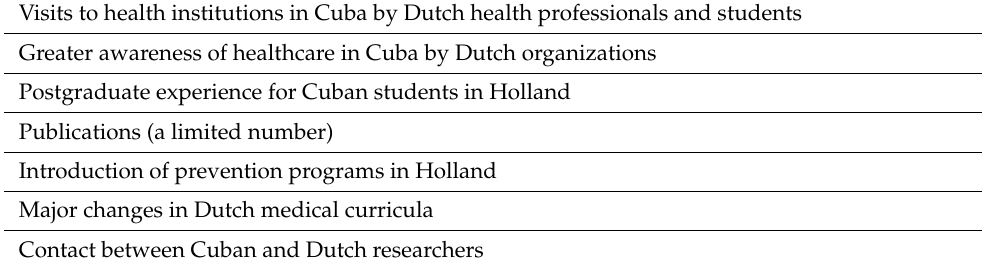
Table 2. Achievements of the exchange. Visits to health institutions in Cuba by Dutch health professionals and students Greater awareness of healthcare in Cuba by Dutch organizations Postgraduate experience for Cuban students in